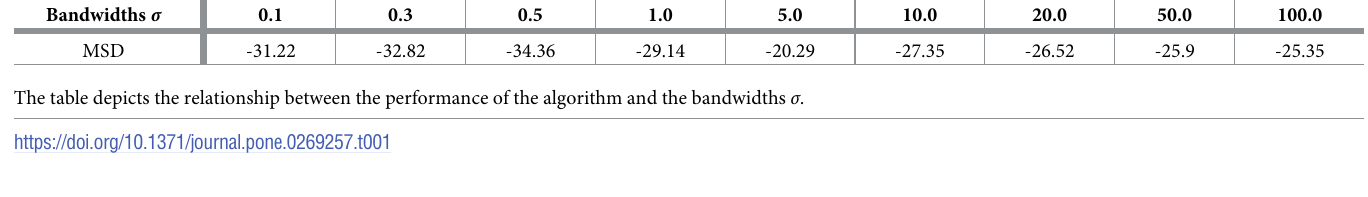
Second, the effect of kernel width σ on algorithm performance is investigated. We set differ- mance of the algorithm, and the other parameters of the algorithm and noise are the same as